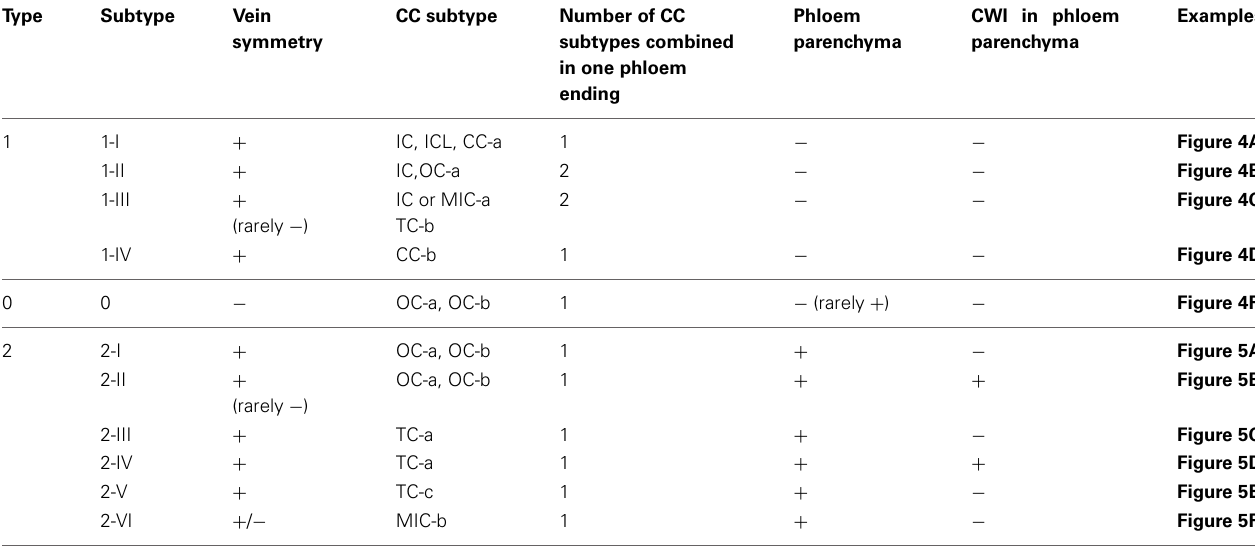
Table 2 | Classification of the minor vein phloem according to its spatial organization in leaves of